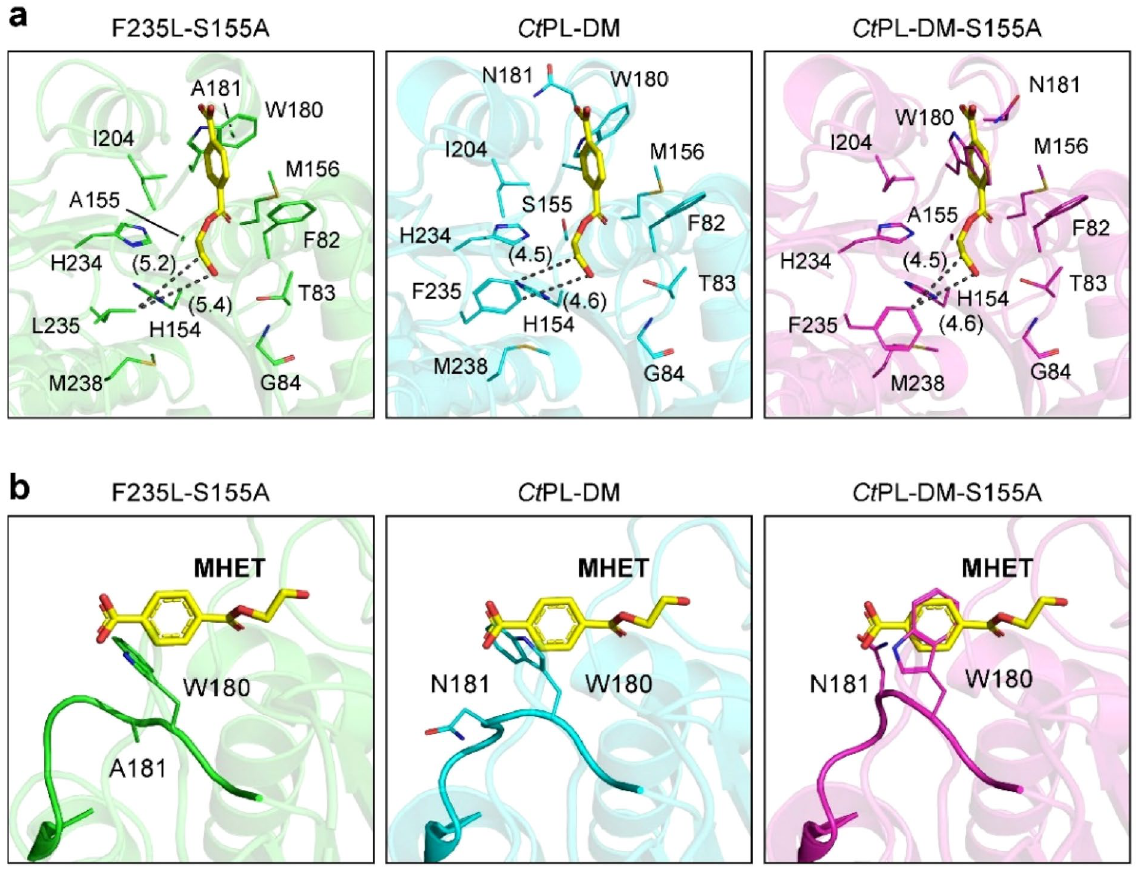
Fig. 4 Structural comparison of Ct PL‑DM variants. The MHET (yellow sticks) modeled from Is PETase/MHET complex structure (PDB ID,7XTW) were displayed in F235L‑S155A (PDB ID, 8IBJ), Ct PL‑DM (PDB ID, 8IAN) and Ct PL‑DM‑S155A (PDB ID, 8IBI). The a MHET‑enzyme interaction networks and b close‑up views of residue 180 and 181 in these structures are displayed. Numbers in parentheses indicate the distance measured by the dashed lines